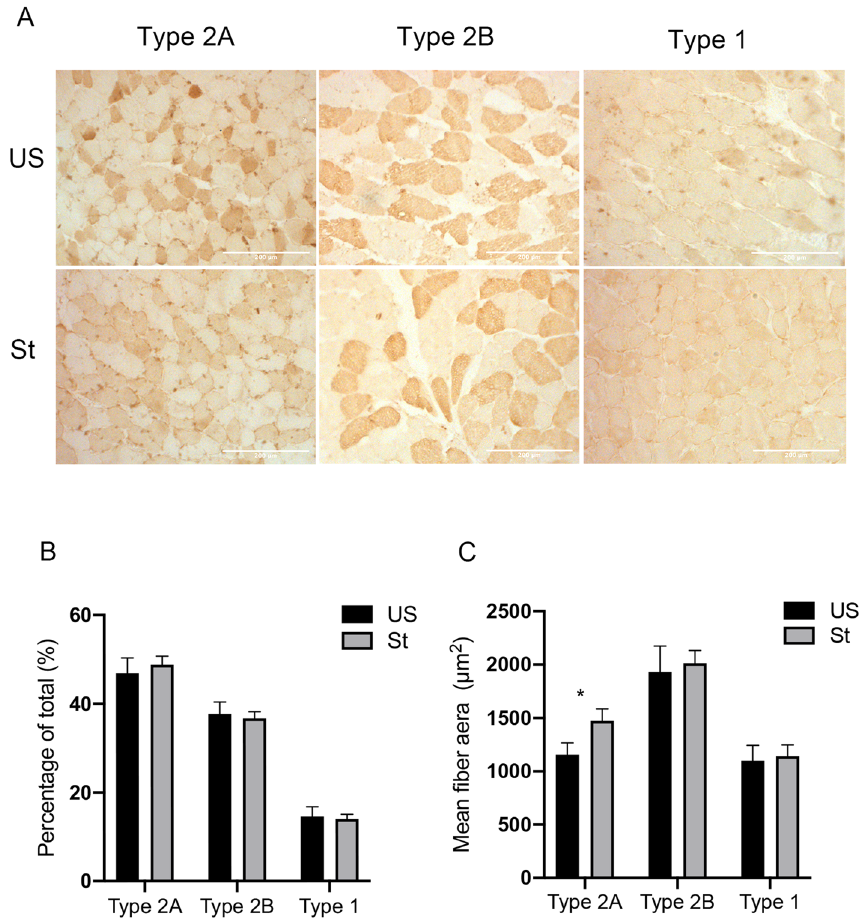
Figure 2. Immunohistochemical analysis of muscle fiber type ( A ) Representative images are shown for type 2A, type 2B, type 1 muscle fiber, visualized with DAB (brown). The bar indicates 200 μm. Magnification: ×100. ( B ) Distribution of fiber types in gastrocnemius muscle. ( C ) Mean cross-sectional fiber area of type 2A, type 2B and type 1. US unstretched, St stretched. Values are expressed as mean ± SEM. *P < 0.05, n =